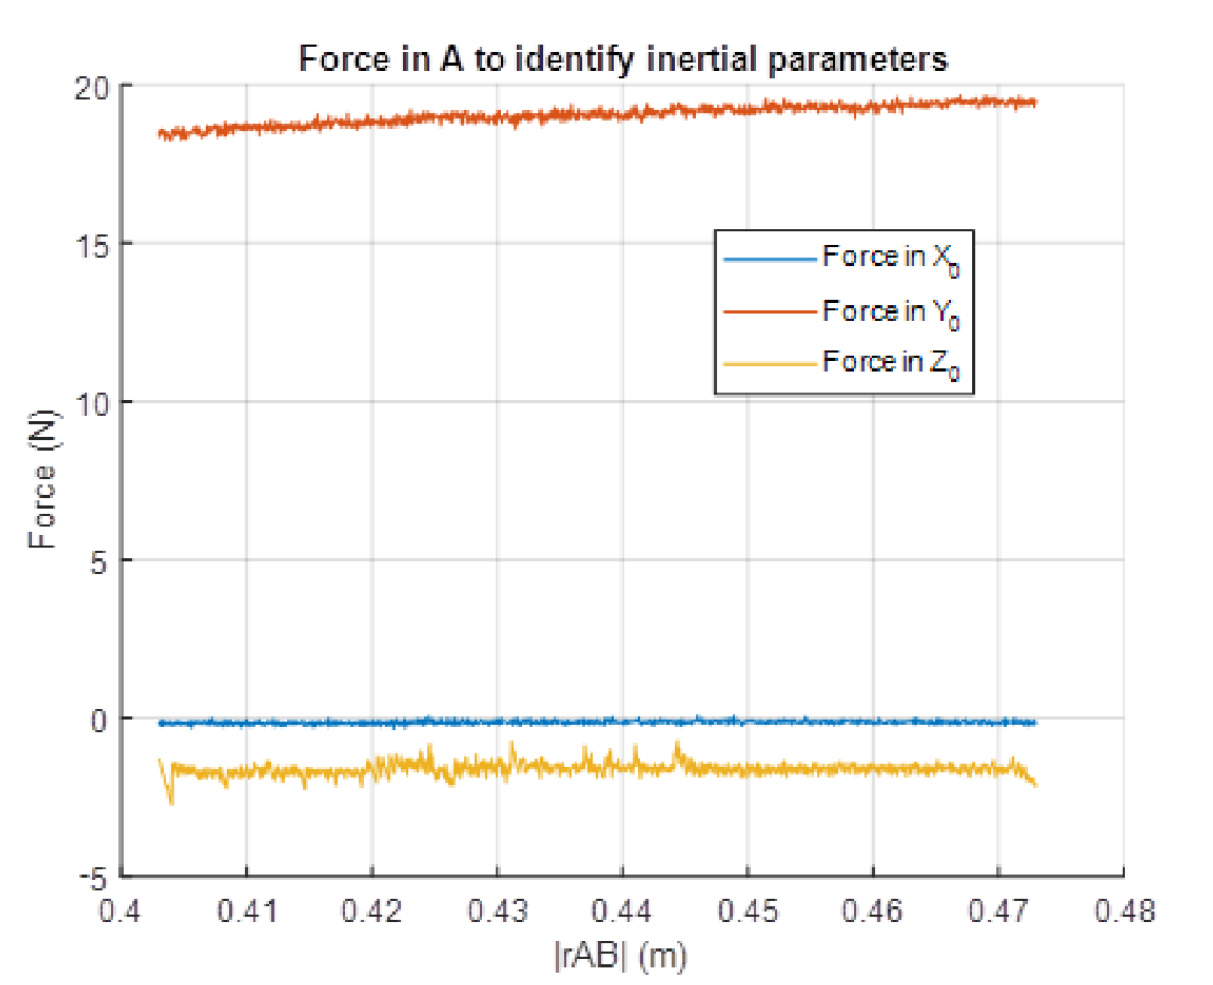
Figure 6. Measured force by the sensor during the identification process. After calculating the inertial parameters for each manipulator, a few random trajectories have been performed. The reaction force appearing at the sensor has been calculated, and it has been compared with recorded data, measuring the method’s error and the effect of friction and the rest of inertial parameters, which were not previously considered (Figure